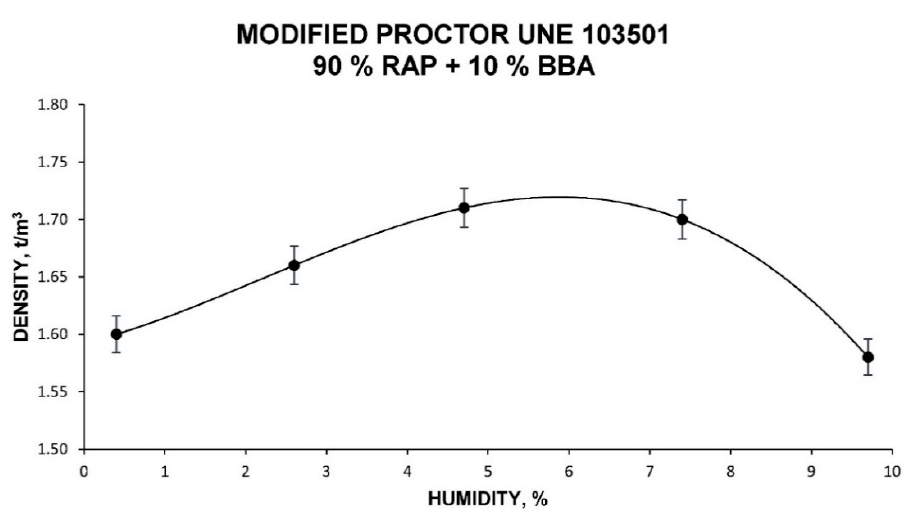
Figure 5. Graph of the modified Proctor compaction test UNE 103501 for the combination of 90% RAP and 10% BBA.